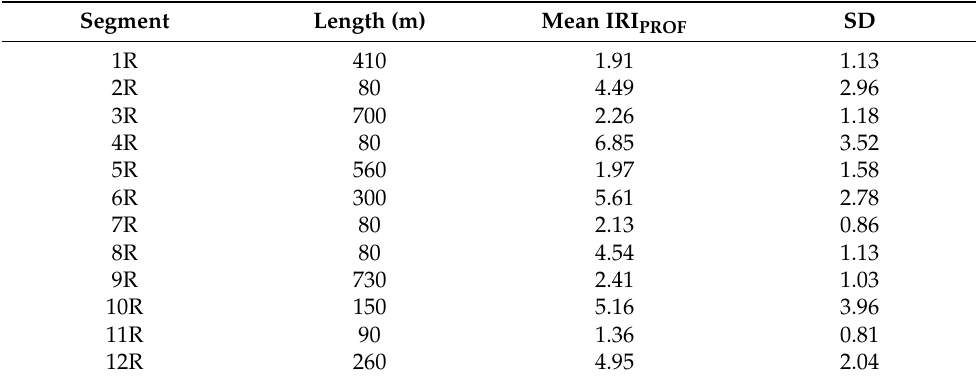
Table 5. Segment characterization (right wheel track).